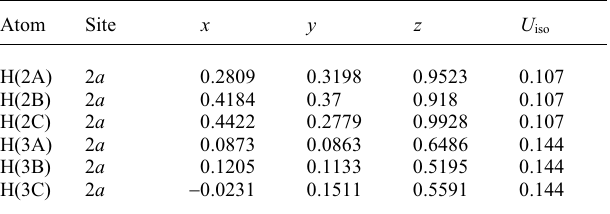
Table 2. Atomic coordinates and displacement parameters (in Å 2 )